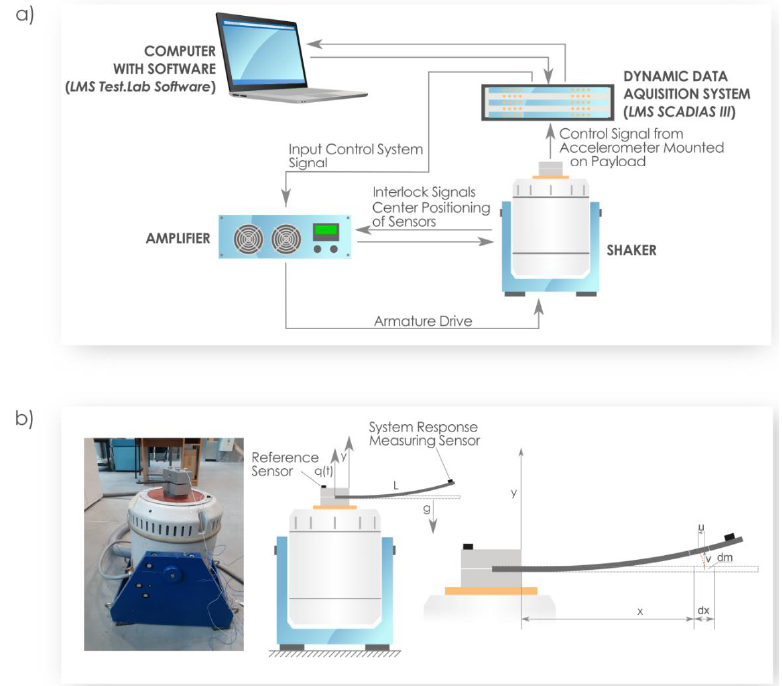
Figure 4. ( a ) The laboratory armature of the electro-dynamical vibration system. ( b ) The experimental set-up and the scheme of the vertically excited composite beam.